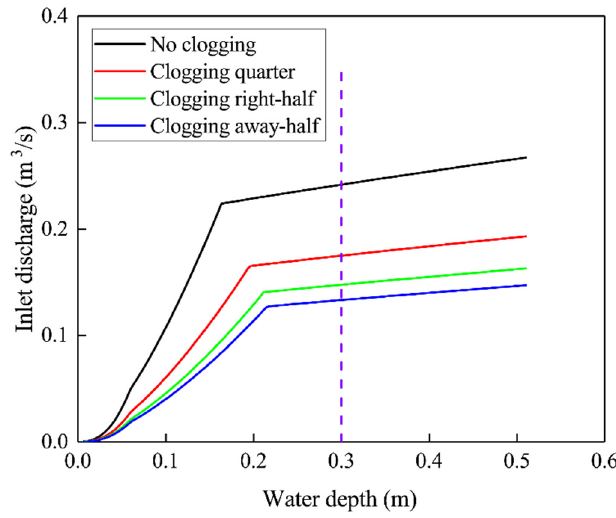
Figure 6. Comparison of the inlet discharge capacity under different clogging conditions.